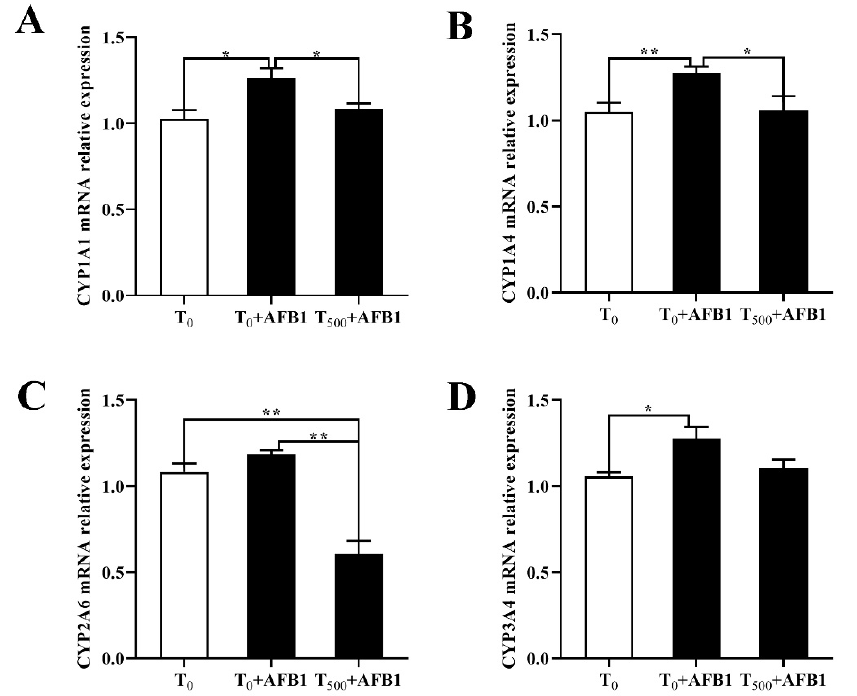
Figure 5. Expression of related phase (I) metabolic enzyme genes in the livers of ducks exposed to AFB1 at 12 h. ( A ) CYP1A1 gene expression in the liver of ducks; ( B ) CYP1A4 gene expression in the liver of ducks; ( C ) CYP2A6 gene expression in the liver of ducks; ( D ) CYP3A4 gene expression in the liver of ducks. Values mean the mean ± SEM, * means p < 0.05, ** means p < 0.01.